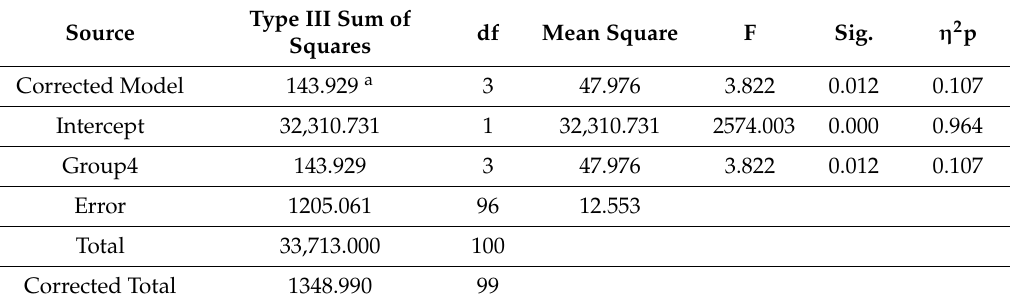
participation in leisure sports activities.